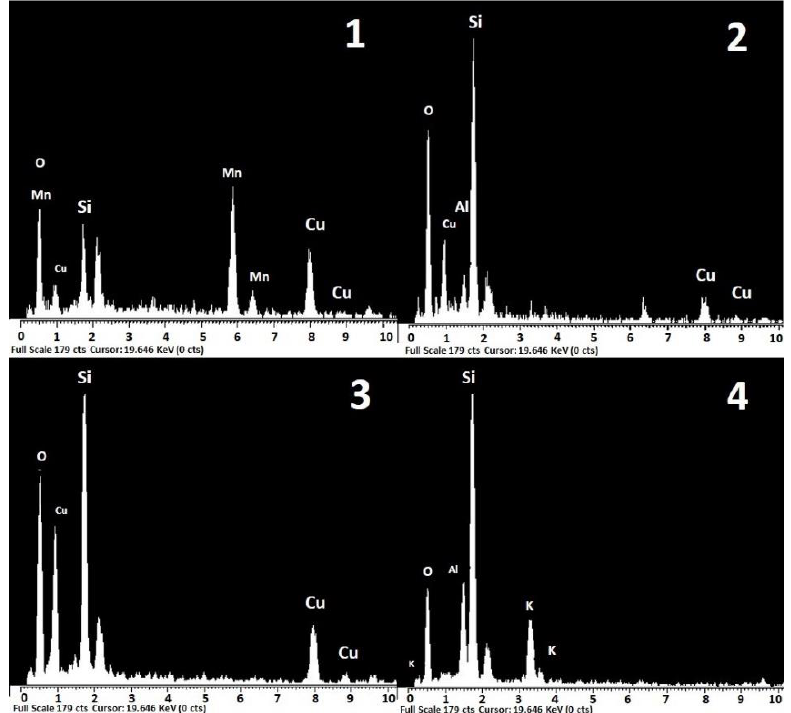
Figure 3. EDS analysis associated with Figure 2. Particles identified: copper pitch (1); chrysocolla (2); dioptase (3); and potassium feldspar (4).